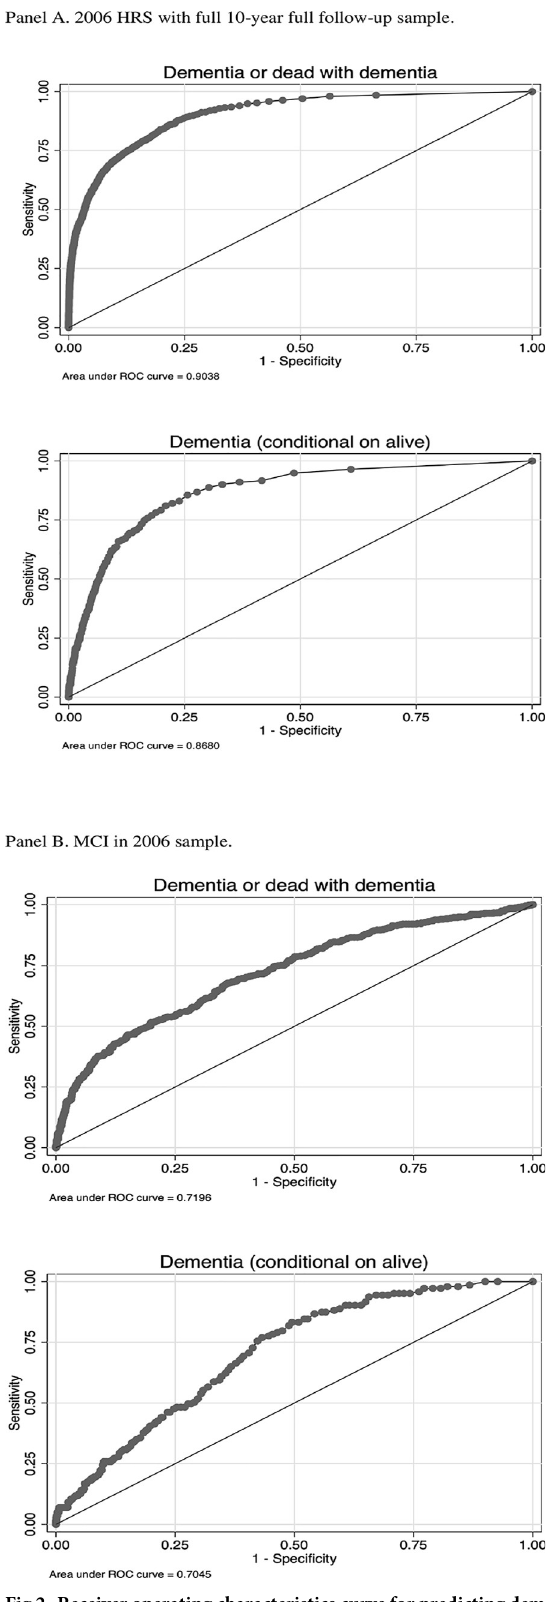
Fig 2. Receiver operating characteristics curve for predicting dementia in 10 years. https://doi.org/10.1371/journal.pone.0274417.g002 PLOS ONE | https://doi.org/10.1371/journal.pone.0274417 September 15,